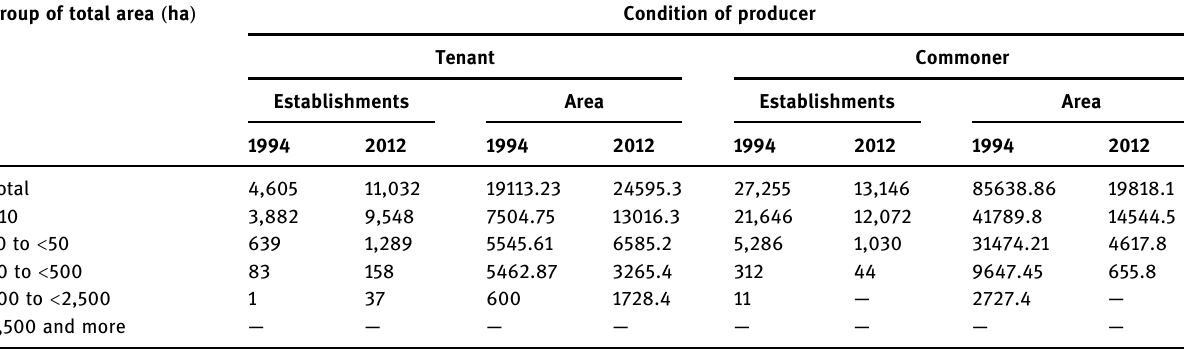
Group of total area ( ha